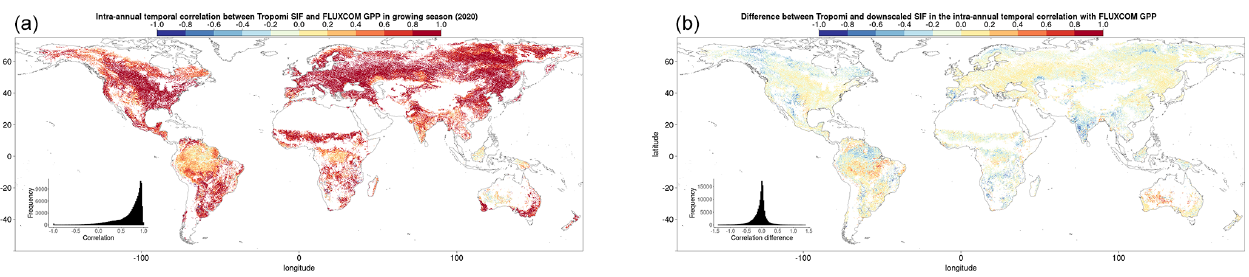
Figure A6. (a) The intra-annual temporal correlation between TROPOMI SIF and FLUXCOM GPP in 2020. (b) The difference (TROPOMI − downscaled) between TROPOMI SIF (2020) and downscaled SIF (2007–2014) in the intra-annual temporal correlation be- tween SIF and FLUXCOM